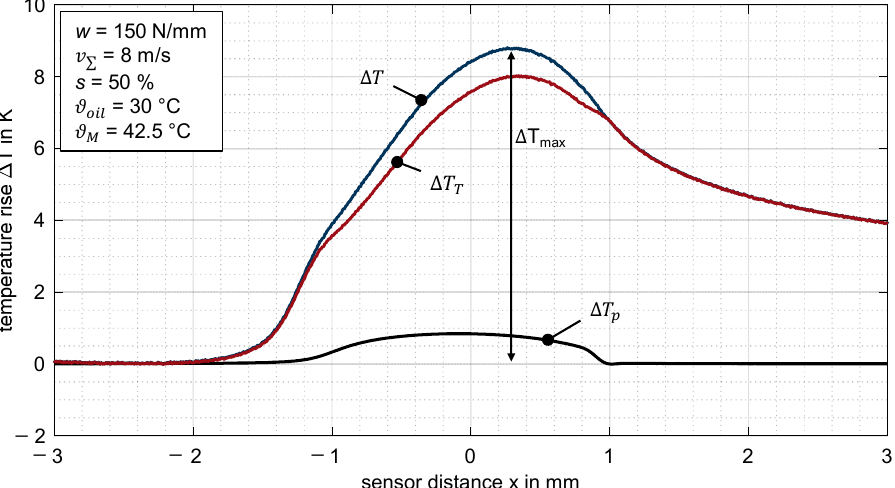
Figure 7. Measured temperature rise ∆𝑇 (cid:3021) , pressure-induced correction temperature ∆𝑇 (cid:3043) and pres- sure-corrected temperature rise ∆𝑇 for the thermoplastic EHL contact ZrO 2 /PEEK (line load w = 150 N/mm, sum velocity 𝑣 ∑ = 8 m/s, slip ratio s = 0%, oil temperature 𝜗 (cid:3042)(cid:3036)(cid:3039) = 30 °C, MIN100).